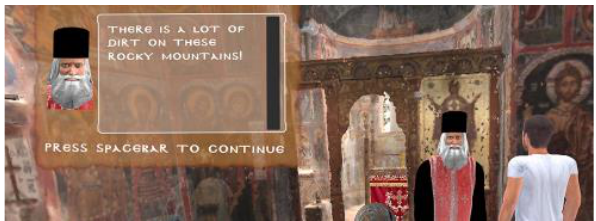
Figure 12. The game environment with Asinou Church presented, A. The riddle introduction inside the interior of the church though the